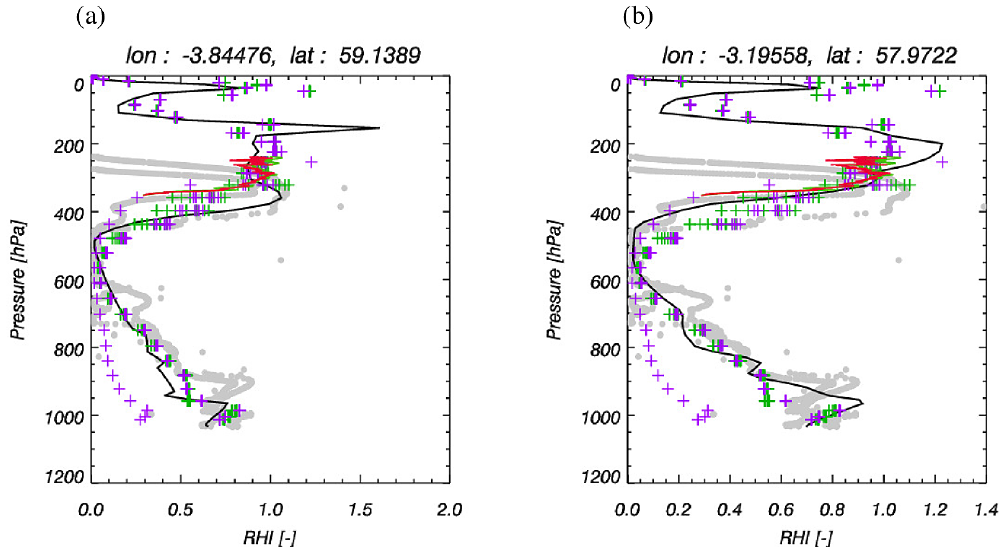
Figure 8. A comparison between the retrievals, dropsonde measurements, in situ measurements and NWP model predictions of RH i plotted against the pressure (hPa) for two different locations. (a) The pixel located at longitude − 3.84 and latitude 59.14 ◦ and (b) the pixel located at longitude − 3.20 and latitude 57.97 ◦ . In (a) and (b) , the retrievals are represented by the purple and green plus signs, dropsonde measurements are the solid grey line and filled grey circles, the General Eastern hygrometer is the solid green line, and the FWVS hygrometer is the solid red